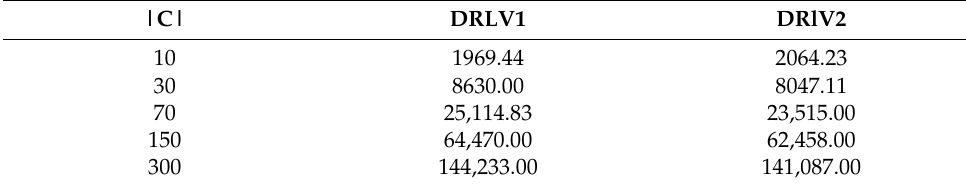
Table 5. Time performance in